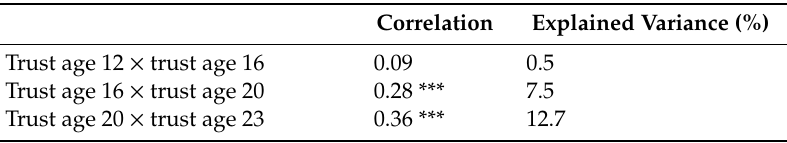
Table 5. Correlations between trust measures at di ff erent